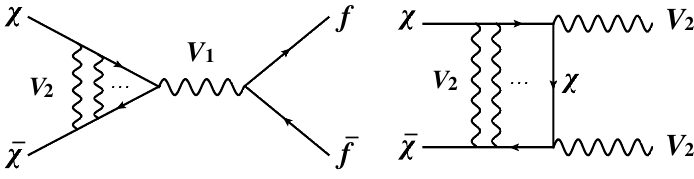
Figure 14 . Illustrations of light V 2 exchanges between annihilating DM particles in the two channels which induce the Sommerfeld